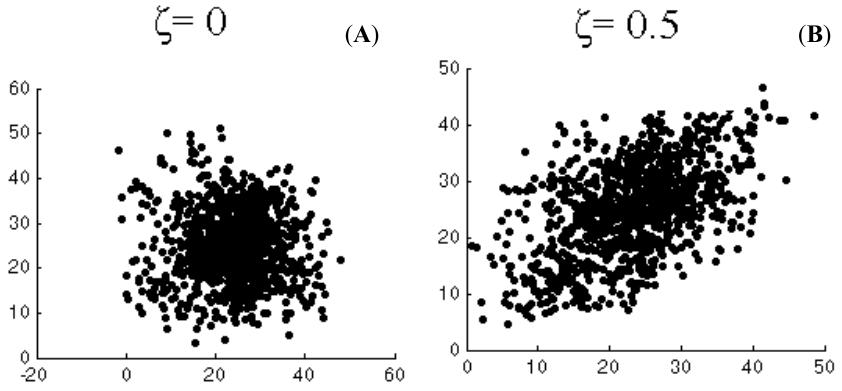
Figure 2. Simulated wind speeds using uncorrelated and correlated random numbers. ( A ) Using uncorrelated random numbers; ( B ) Correlated random numbers with ζ =